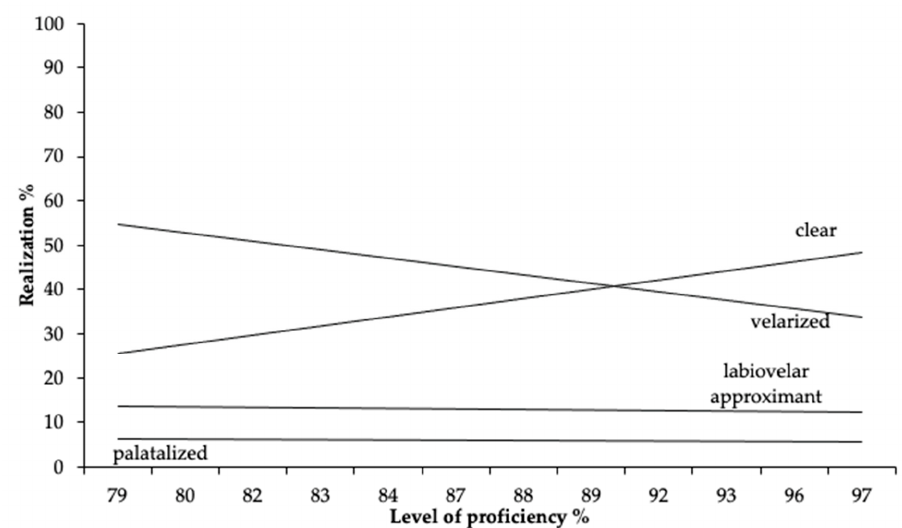
Figure 1. The effect of level of proficiency on the realization of the L3 Polish lateral (in percentages).